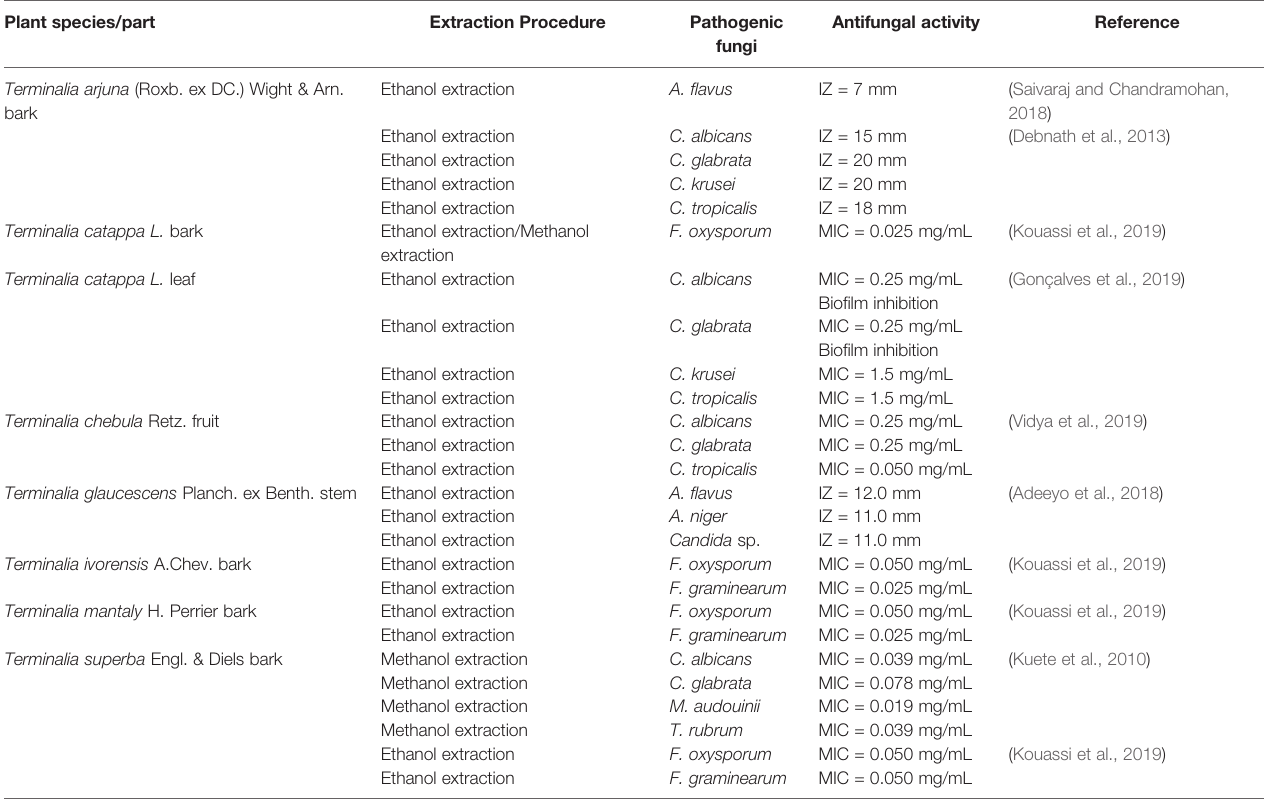
TABLE 8 | Antifungal activity of Terminalia sp. against pathogenic